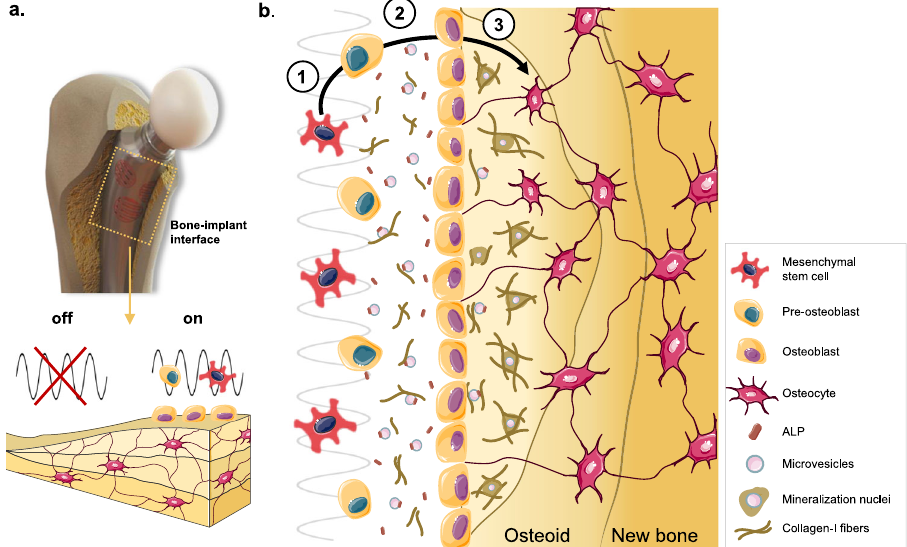
Fig. 7 High osteogenic performance of cosurface capacitive stimulators at HF. Future innovative bioelectronic implants will deliver capacitive electrical stimulation of high frequency (HF, 60 kHz) around the bone – implant interface. HF stimuli promote osteodifferentiation of mesenchymal stem cells into pre-osteoblasts (1) and further proliferation and maturation of these into osteoblasts (2). HF stimulation induces active secretion of collagen-I, alkaline phosphatase (ALP), and microvesicles with membranar ALP and key matrix proteins. These microvesicles progress into mineralization nuclei for hydroxyapatite crystals early deposition, alongside with collagen-I fi bers that are rearranged into a tight matrix. The mineralized matrix progressively entraps last-stage bone cells, the osteocytes (3) in the newly formed osteoid, that gradually becomes the new bone. Image elements taken from the Servier Medical ART free online vector image